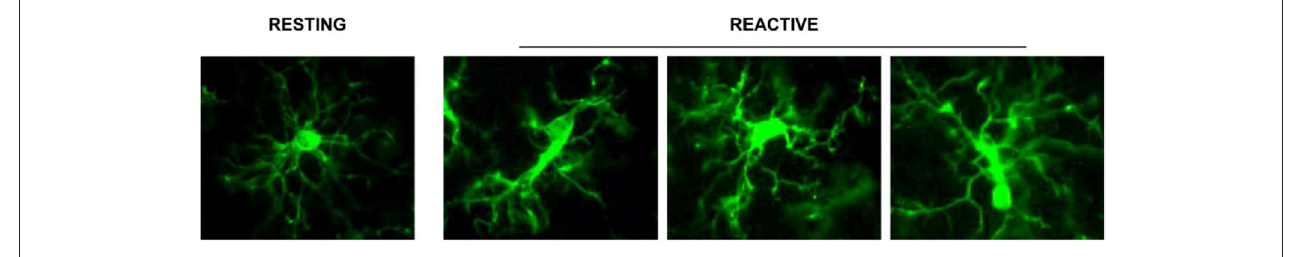
FIGURE 1 | Representation of the different stages of microglia activation, marked with the anti IBA1 antibody [from Cerbai et al. (2012)].